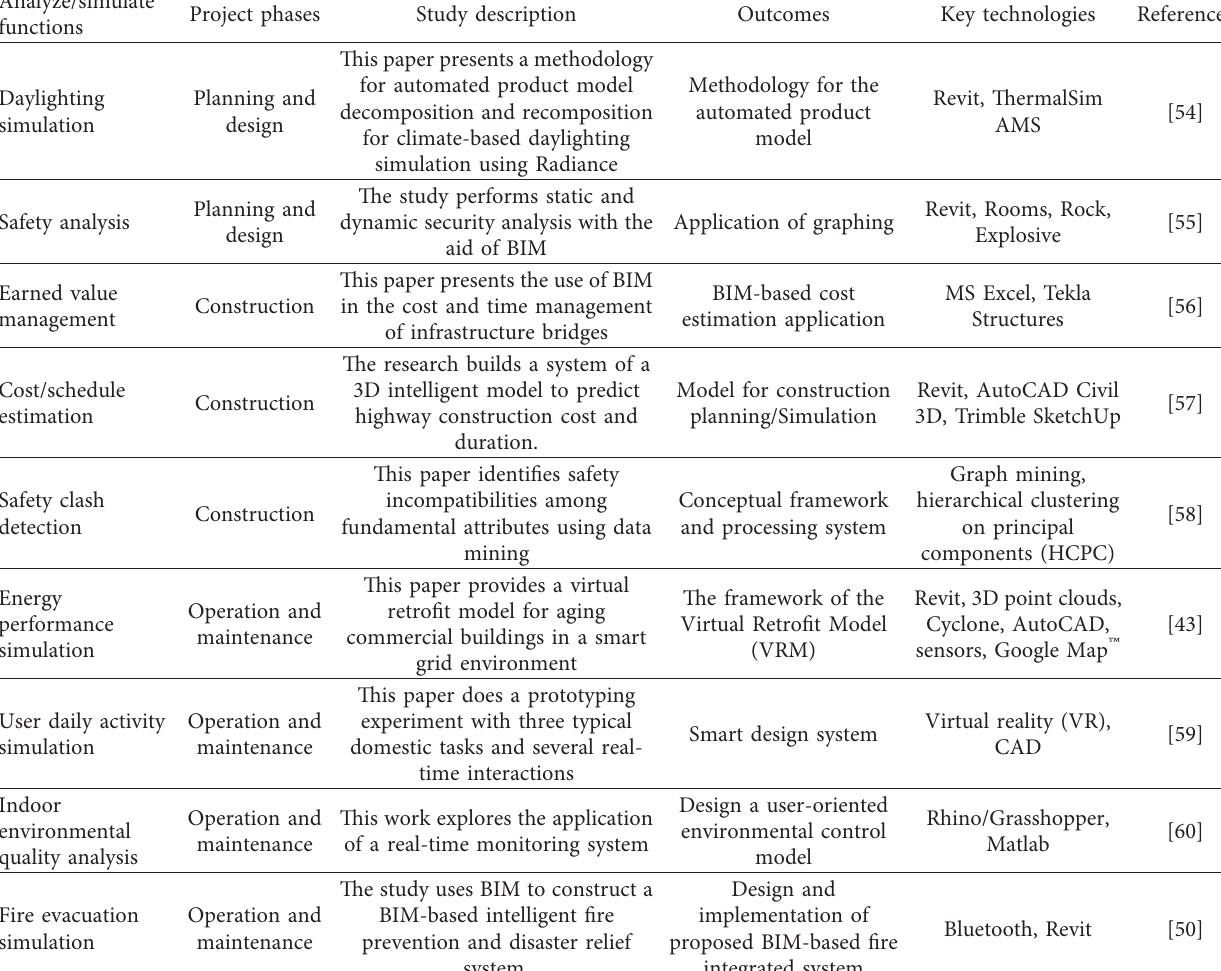
Table 2: BIM-supported analysis and simulation functions of smart buildings.